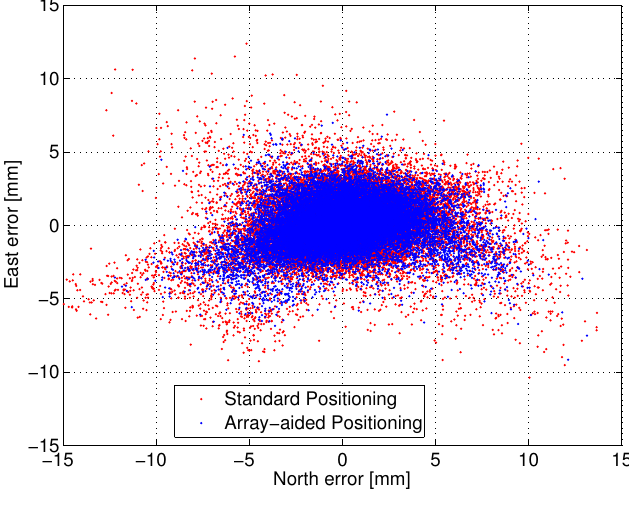
Figure 5. North-east scatter plot of the ambiguity-fixed baseline estimation using static data with epoch-by-epoch processing (20-m baseline).